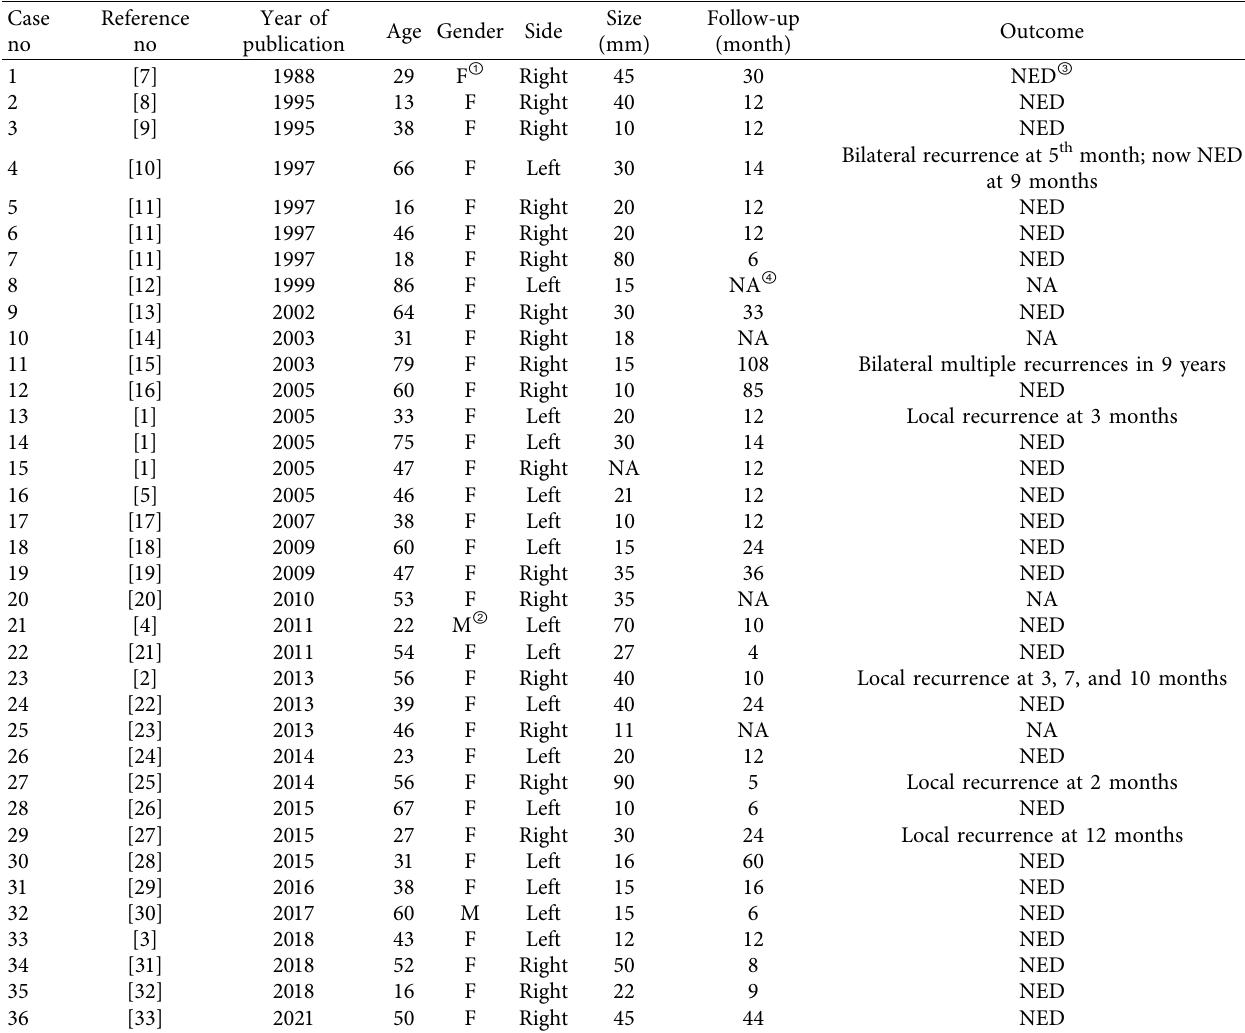
Figure 3: ALK positive expression in spindle tumor cells. IHC 400 × . (b): the testing result of ALK by separation probes of FISH, showing ALK gene rearrangement (red and green signals were Table 1: Clinical features of the breast IMT cases in PubMed.